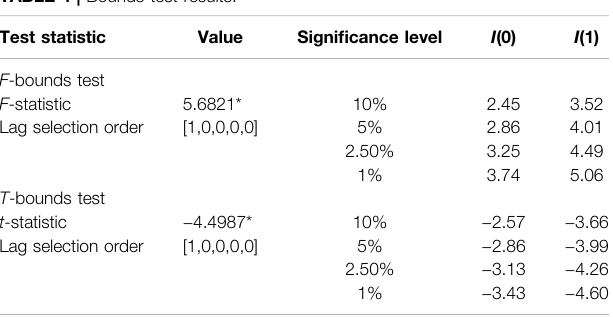
TABLE 4 | Bounds test results.